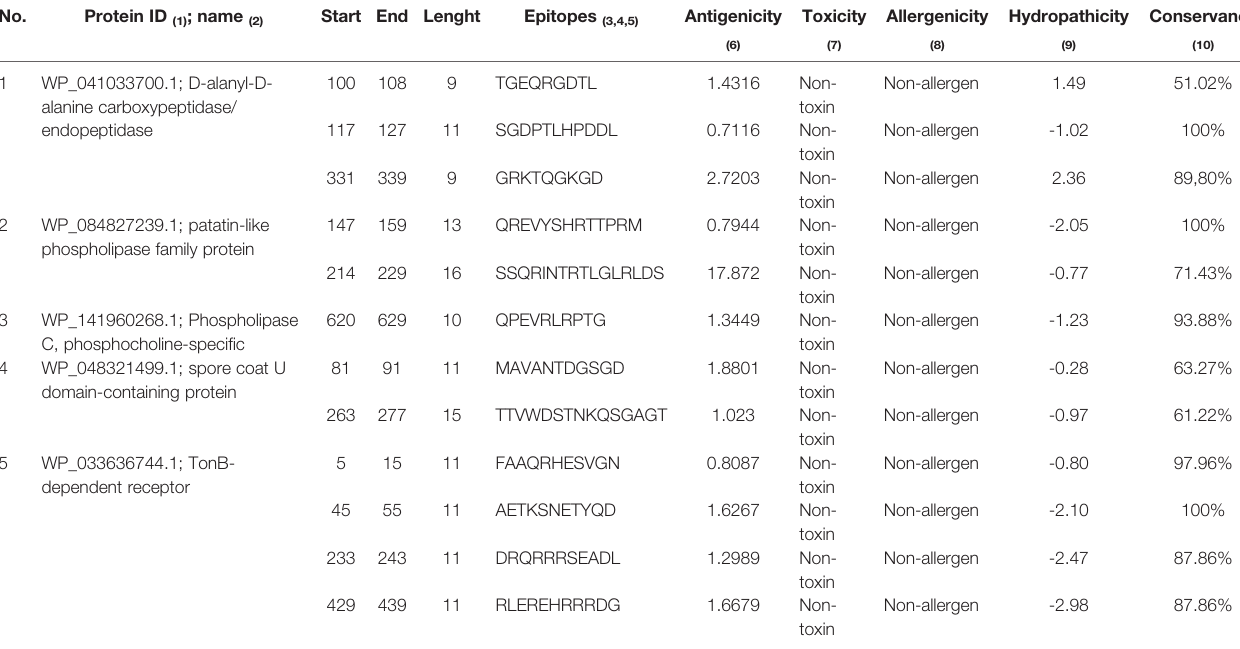
TABLE 4 | Identi fi cation of B-cell epitopes and antigenicity, toxicity, allergenicity and hydropathicity prediction of selected epitopes.